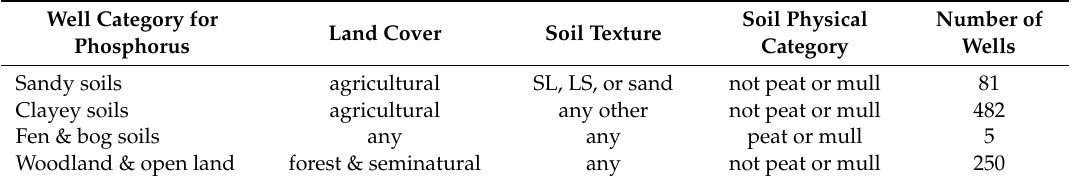
Table 2. Well categories for phosphorus. SL = sandy loam; LS = loamy sand.